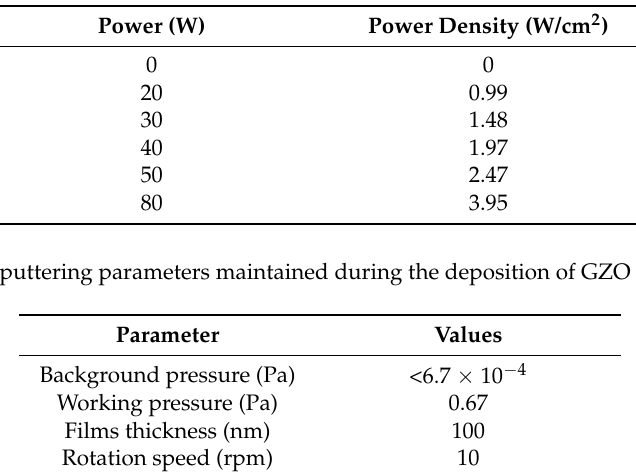
Table 2. The power densities applied on Ga 2 O 3 target.